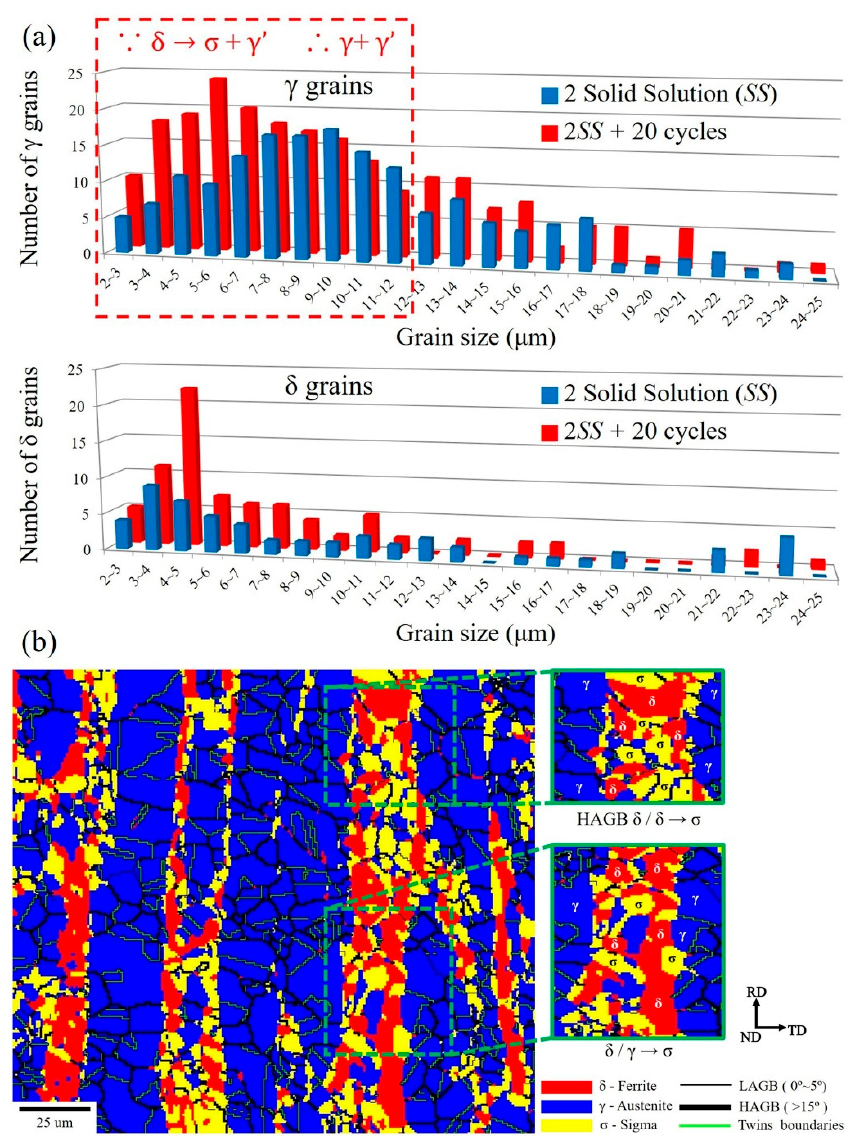
Figure 10. ( a ) Comparison of grain size distribution for the γ and δ phases under thermal cycles at 2 SS and 2 SS + 20 cycles; ( b ) EBSD images for twin boundaries depicted with green lines, the δ , γ and σ phases at 2 SS + 20 cycles.